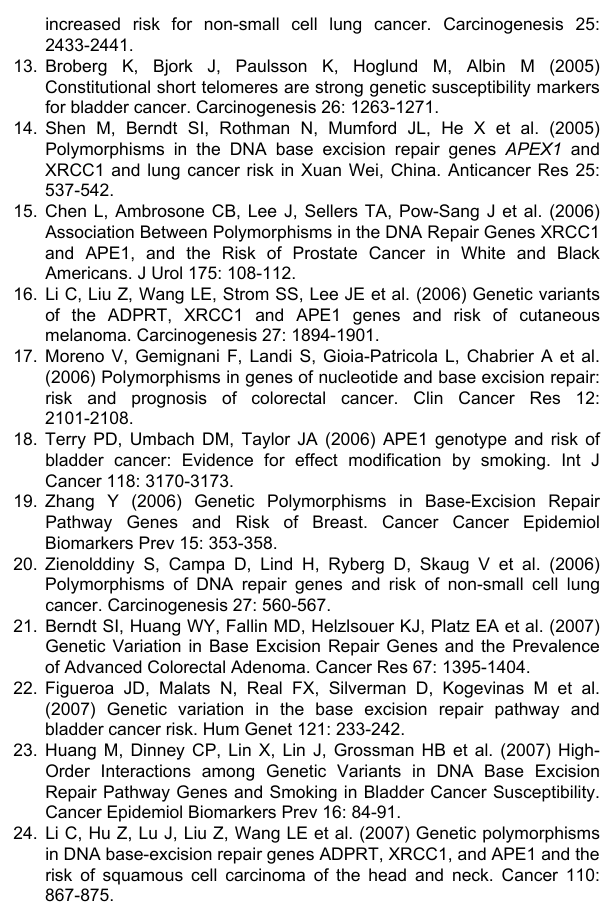
Figure S1. Forest plots of the lung, bladder, colorectal cancer (the upper panel), and prostate, breast, gastric cancers (the lower panel) in subgroup analyses by cancer type for the APEX1 Asp148Glu polymorphism under the allelic model. Figure S2. Forest plots of the Caucasians (the upper panel), Asians (the middle panel), African-Americans and mixed populations (the lower panel) in subgroup analyses by ethnicity for the APEX1 Asp148Glu polymorphism under the allelic model.